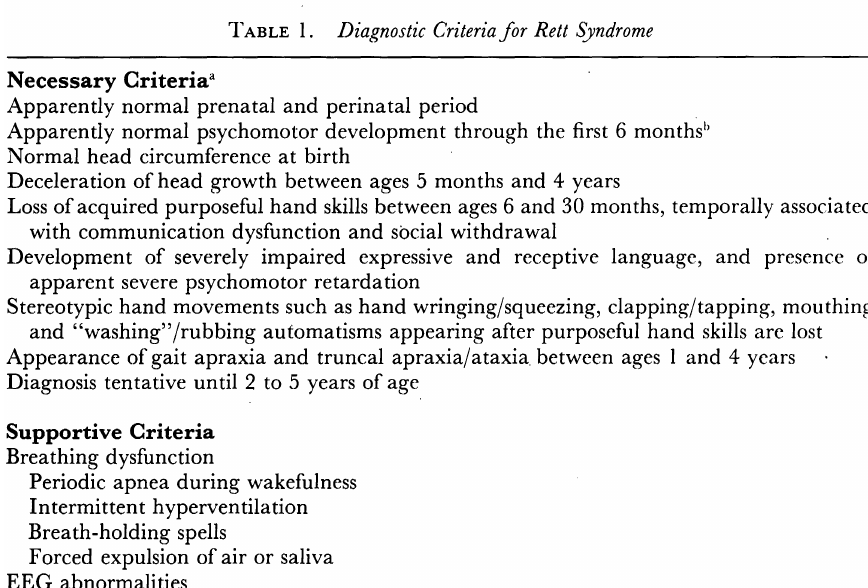
TABLE 1. Diagnostic Criteria for Rett